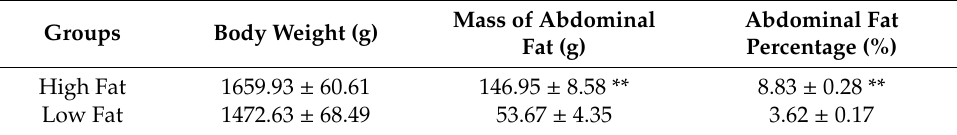
Table 1. Slaughter data of female